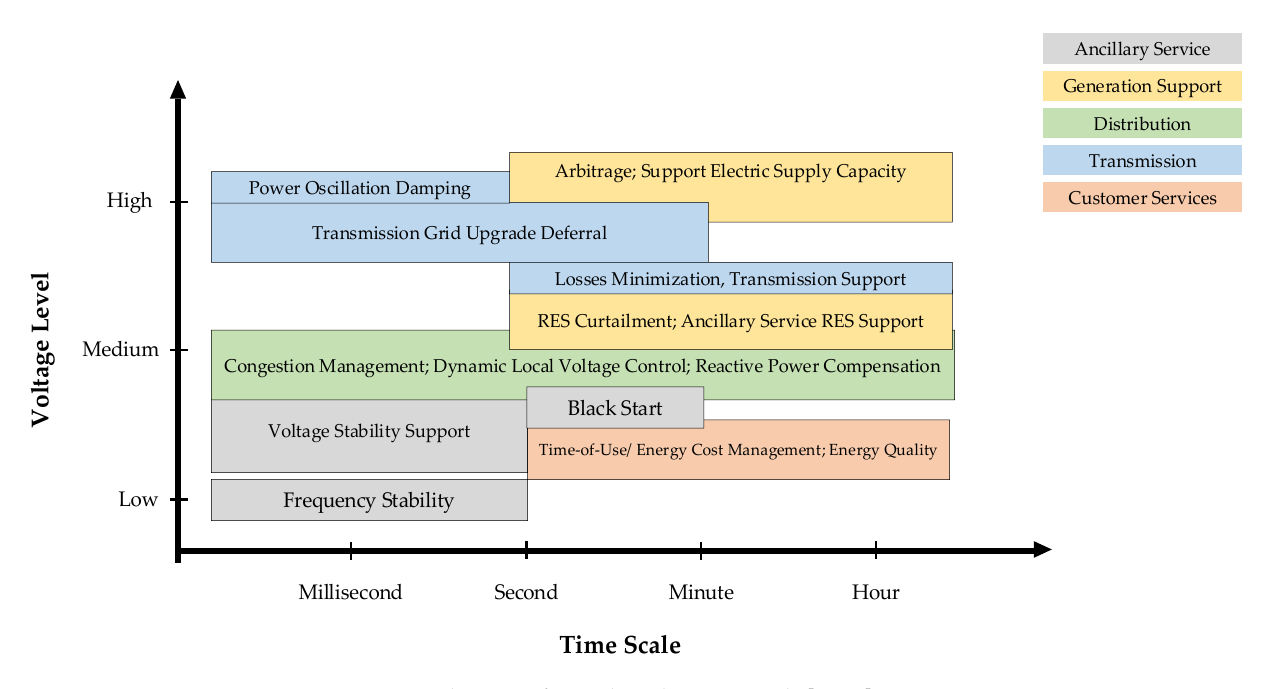
Figure 4. Application of BESS based on time scale [43,44].